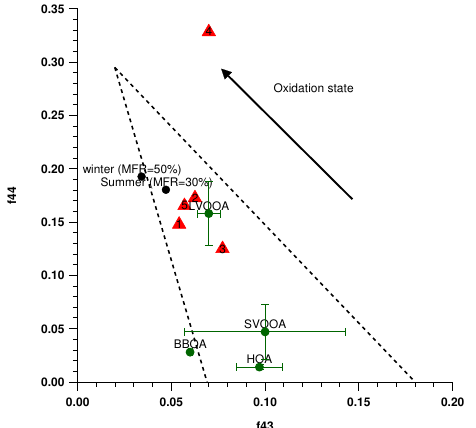
Figure 8: f44 vs. f43 of each LV-OOA factors in the triangle space determined by Ng et al. (2010). The green points referred to the average values (+/- standard deviation) of factors used by Ng et al. (2010). Red triangle and numbers referred to different examples of LV-OOA factors (1: Hersey et al. (2011), 2: Lanz et al. (2007), 3: Ulbrich et al. (2009), 4: Robinson et al. (2011), 5: Crippa et al. (2013) illustrating the individual variability of LV-OOA.